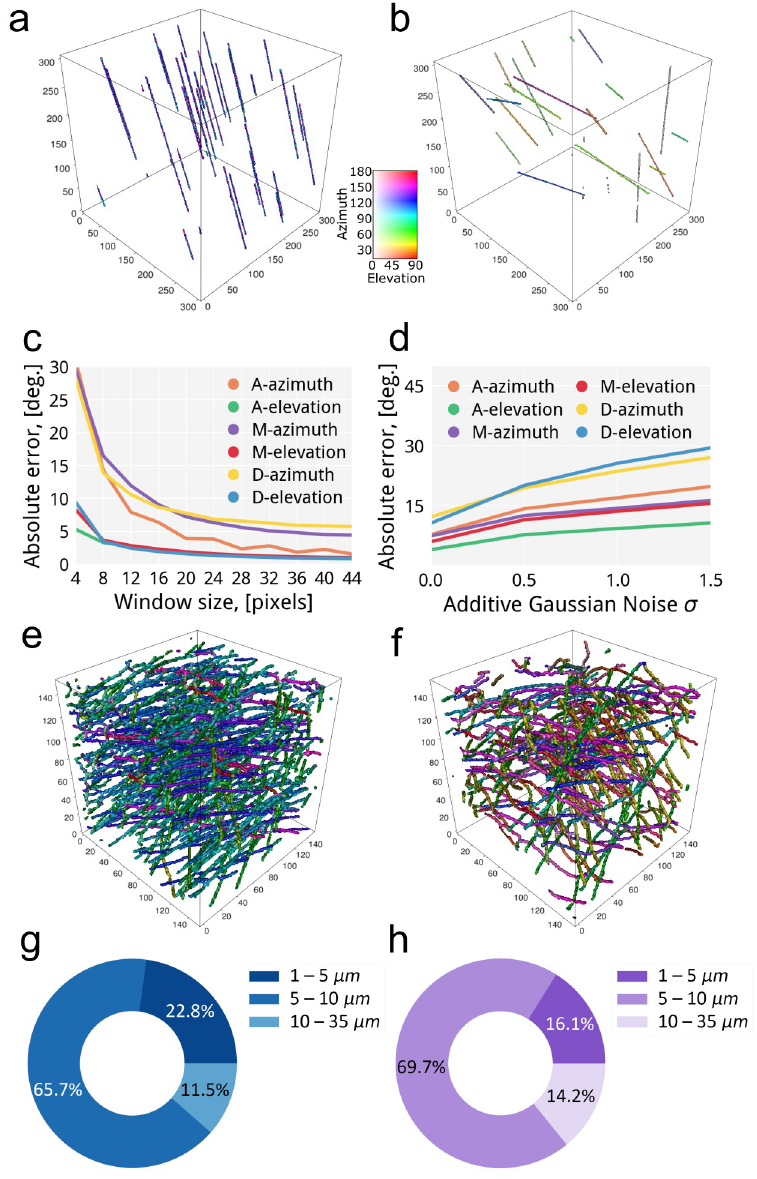
Fig 5. The accuracy analysis of the orientation algorithm: a,b) the visualization of the orientation estimation of the generated datasets with aligned and disordered configuration for 32 pixels of window size (the generated dataset is shown in Fig 1(a)–1(c)); c) the absolute error of orientation quantification using the implemented algorithm on the generated datasets without noise to determine the optimal window size; d) the dependency of absolute angular error derived from the results produced by the implemented algorithm on the generated datasets contaminated with different noise levels; e,f) the visualization of the orientation estimation of the wPCL and rPCL scaffolds; g,h) the measurements of fiber diameter distribution within scaffolds with well-aligned and randomly oriented